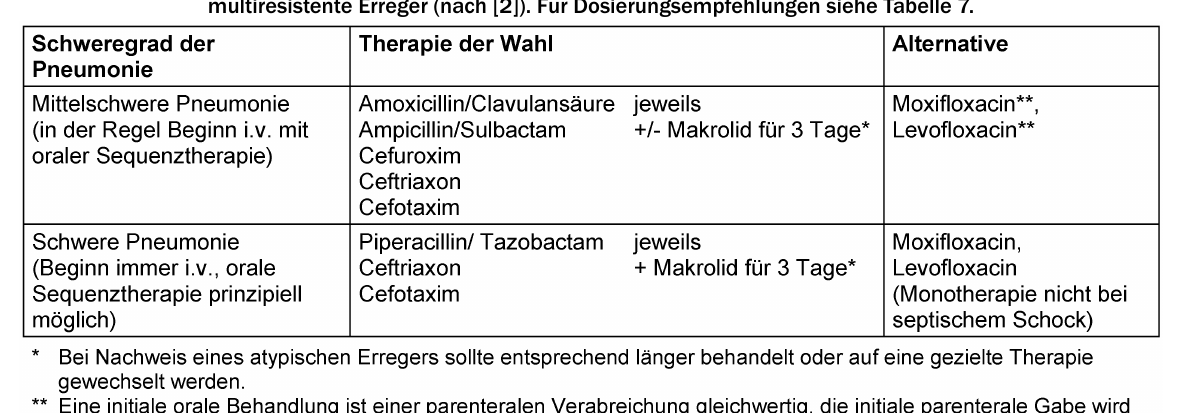
Tabelle 4: Empfehlung für die kalkulierte Initialtherapie bei mittelschwerer und schwerer hospitalisierter CAP ohne Risiko für